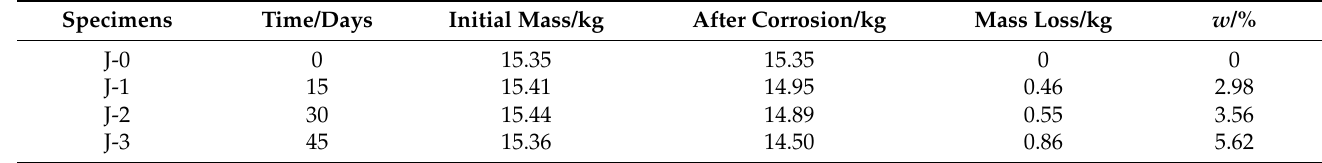
Table 5. Results of accelerated corrosion of the bolt-sphere joints with